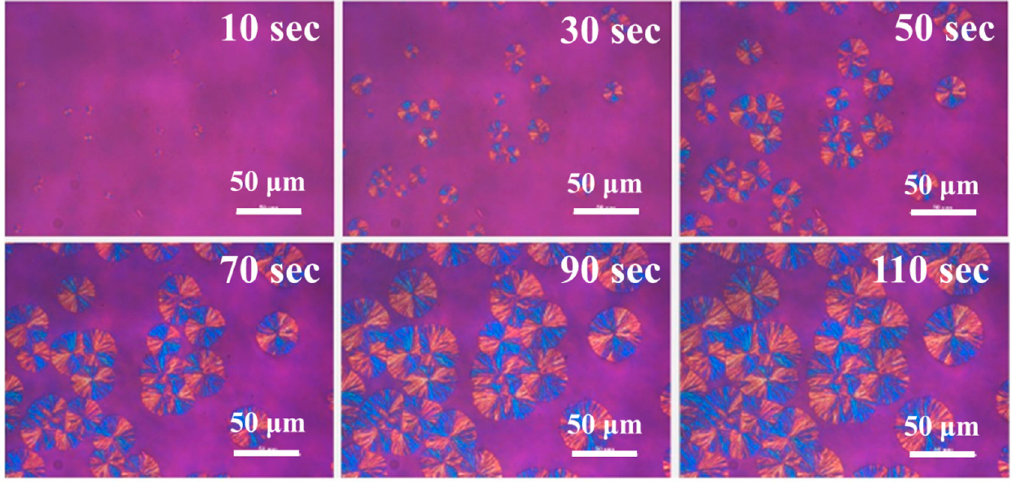
Figure 12. Spherulite morphology of PBT- co -PTMEG-40 copolymer at 160 °C as a function of time. Spherulite growth rates as a function of T c for PBT- co -PTMEG copolymers were calculated, as